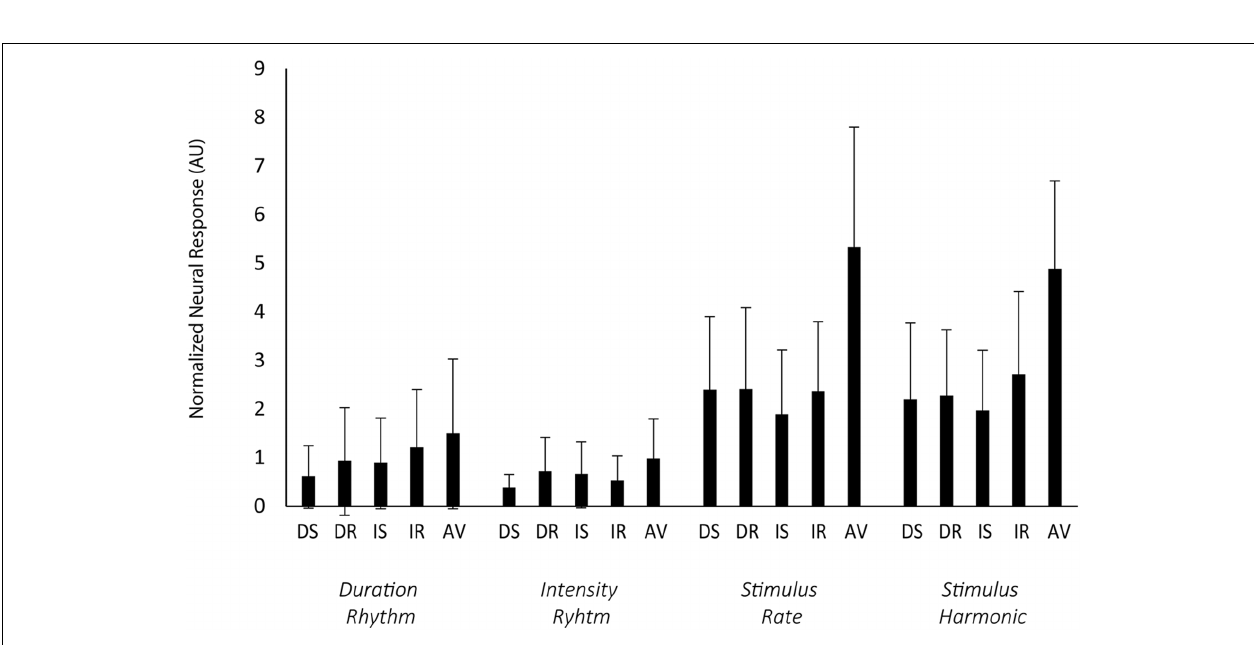
Frontiers in Human Neuroscience |